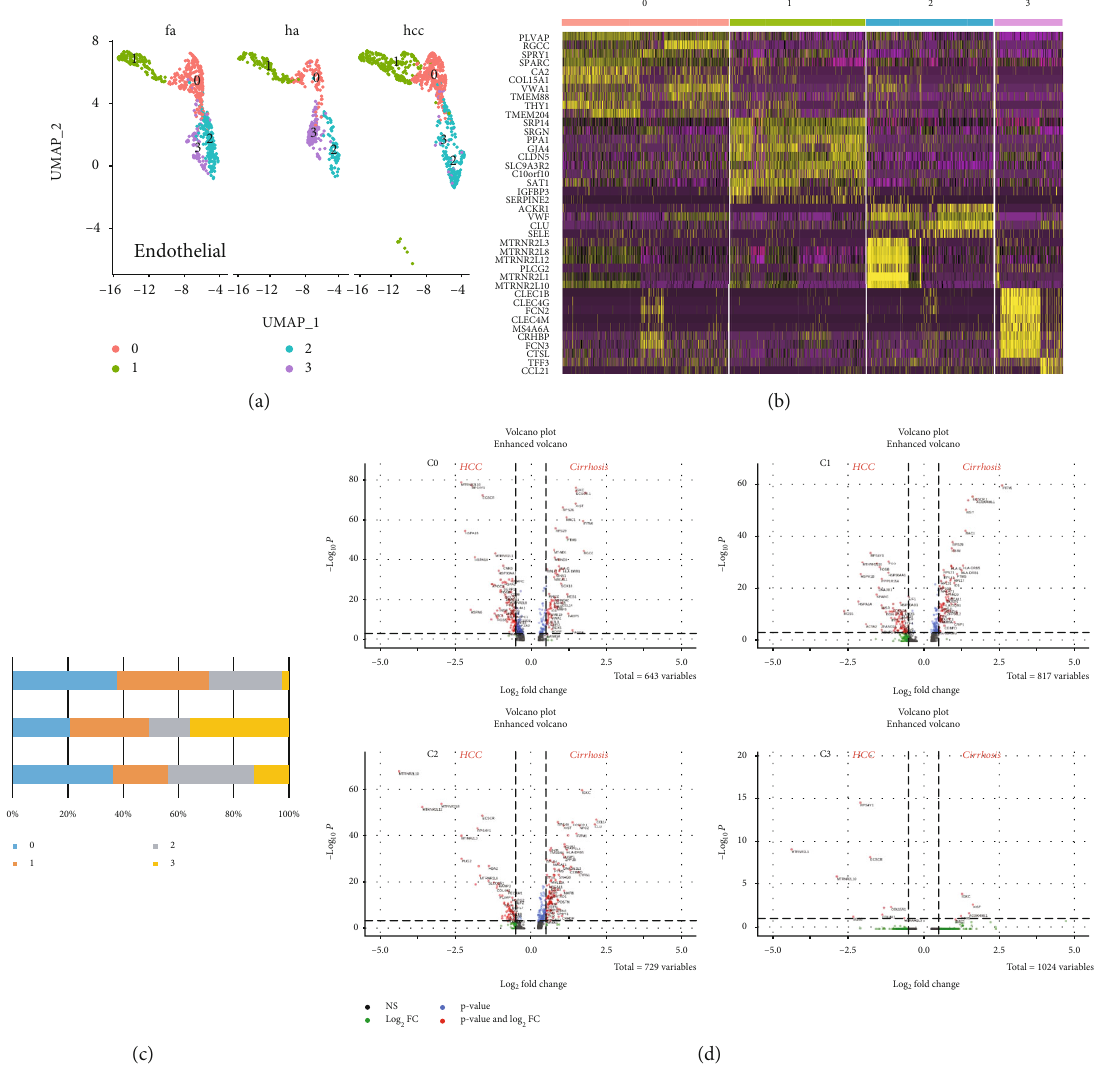
Figure 2: Subcluster analysis and quanti fi cation of the liver endothelial cells. (a) UMAP diagram depicts 4 subtypes of the endothelial cells. (b) Heat map annotated di ff erential genes of 4 endothelial cell subtypes. (c) Bar graphs quantify and compare the proportion of endothelial cell subtypes of healthy, fi brosis, and HCC patients. (d) Volcano plots show the DEGs between fi brosis and HCC in 4